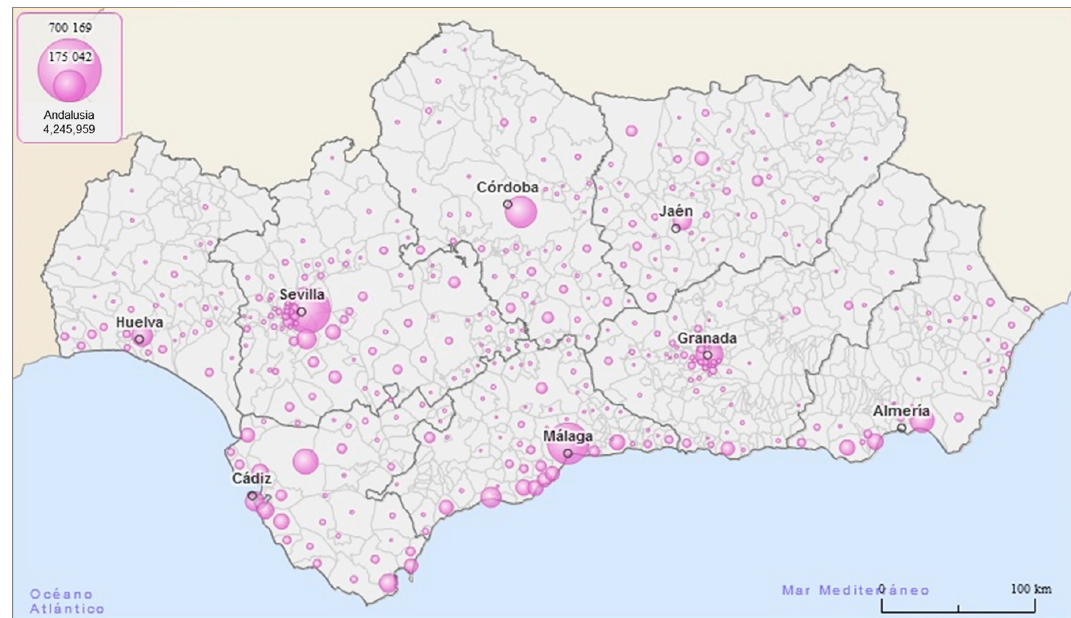
Figure 1. Andalusia (southern Spain) and its administrative division into eight provinces and 771 municipalities. Colored circles represent the female population of each municipality, which is directly proportional to the circle size.